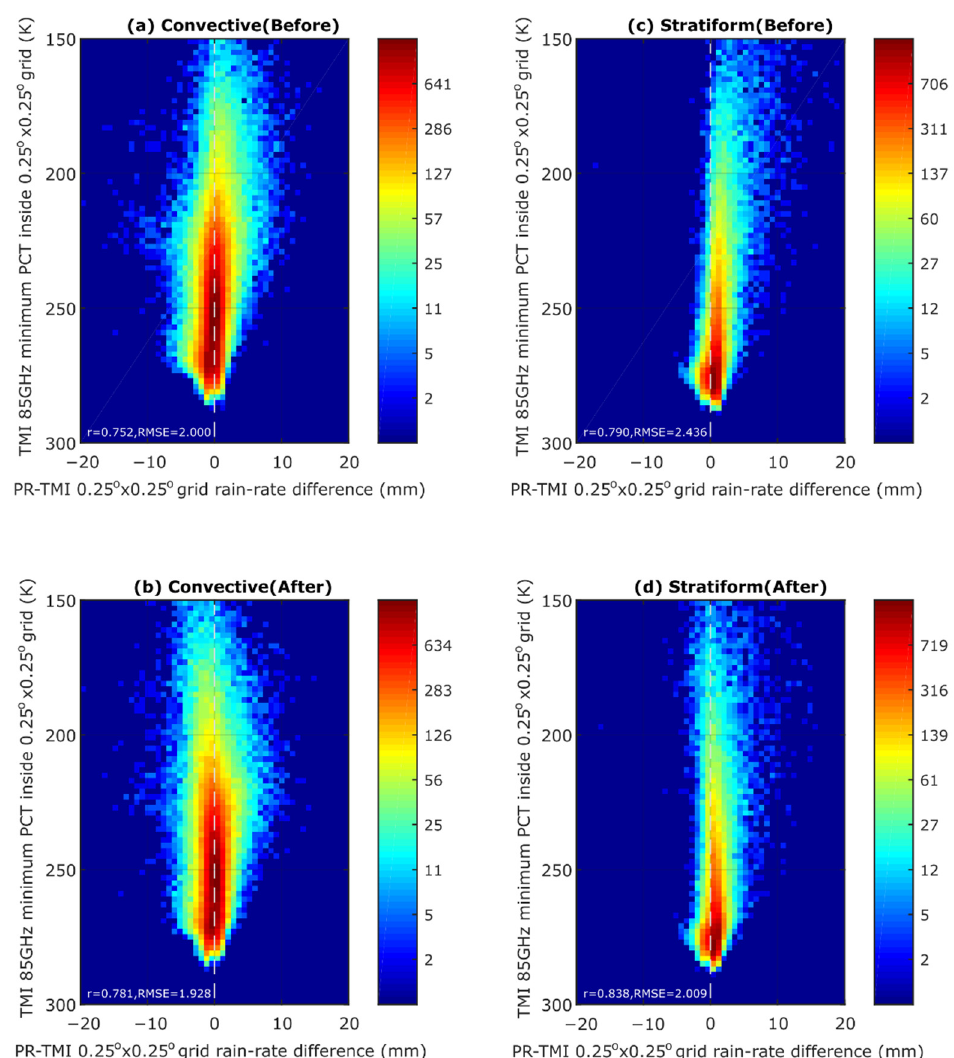
Figure 9. Comparison of the adjustment result during the La Niña event in 2009. ( a ) Before the adjustment was implemented for convective precipitation, ( b ) after the adjustment was implemented for convective precipitation, ( c ) before the adjustment was implemented for stratiform precipitation, and ( d ) after the adjustment was implemented for stratiform precipitation (source: data processing).